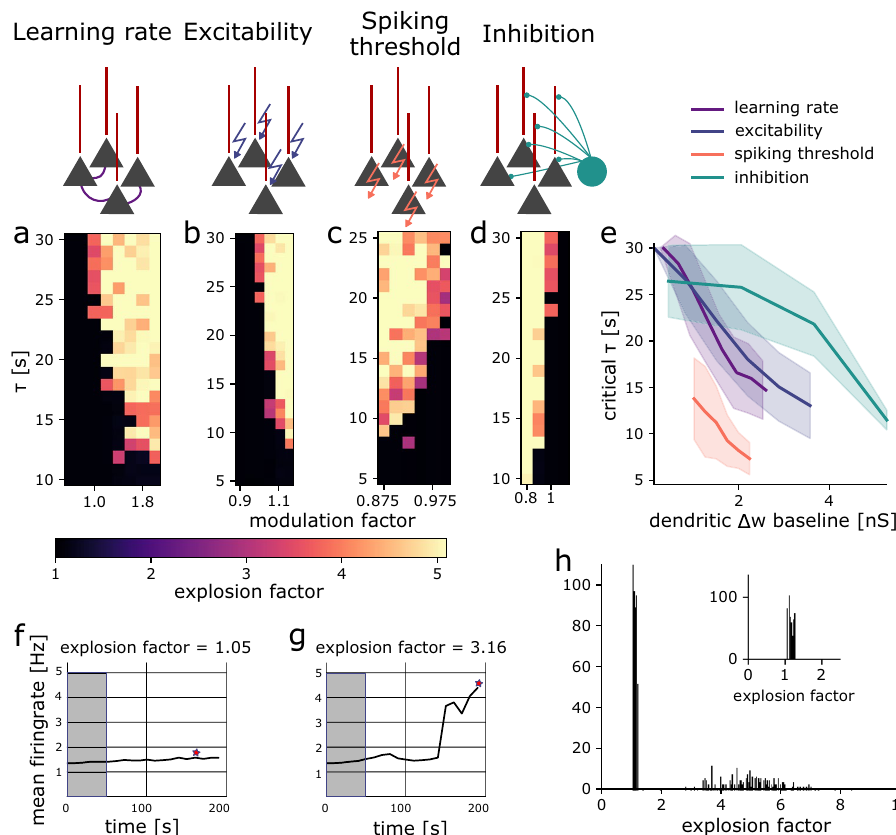
Figure 2. Gating plasticity increases stability. ( a – d ) Explosion factor as a function of homeostatic time constant τ and the respective gate ( a ) learning rate, ( b ) excitability, ( c ) spiking threshold (a measure of intrinsic excitability), ( d ) inhibition. ( e ) Comparison of the critical homeostatic time constant τ crit for different gates, plotted as a function of baseline dendritic weight change to allow for comparison. ( f – g ) Illustration of the explosion factor. The star indicates the maximum firing rate of each simulation that was taken for the measurement of the explosion factor. The grey area denotes the reference firing rate at the beginning of the simulation, which was taken to calculate the explosion factor. ( f ) Example network simulation, where the firing rate does not explode (with explosion factor 1.05). ( g ) Example network simulation, where the firing rate explodes (with explosion factor 3.16). ( h ) Distribution of explosion factors. Inset: zoom into the